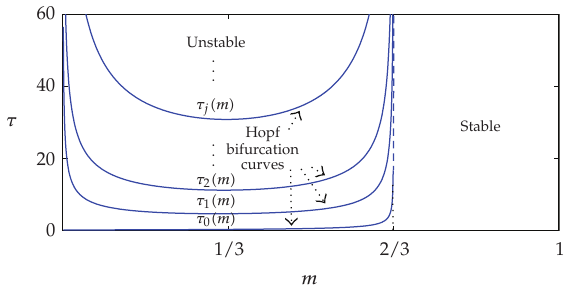
Figure 1: Hopf bifurcation set on m − τ